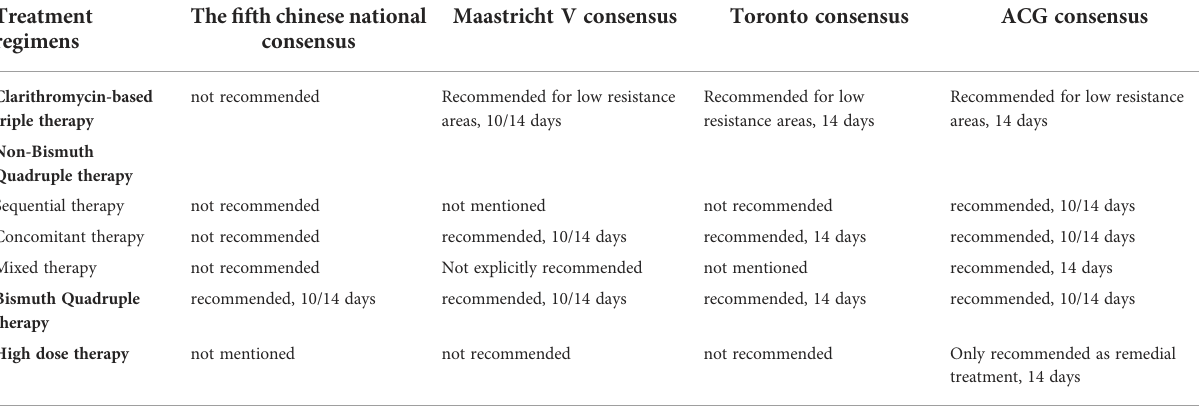
TABLE 2 International consensus opinion on the recommended primary treatment regimen for H. pylori